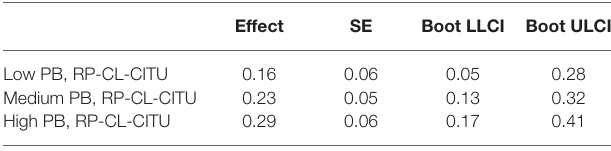
TABLE 4 | Conditional indirect effect at specific values of power